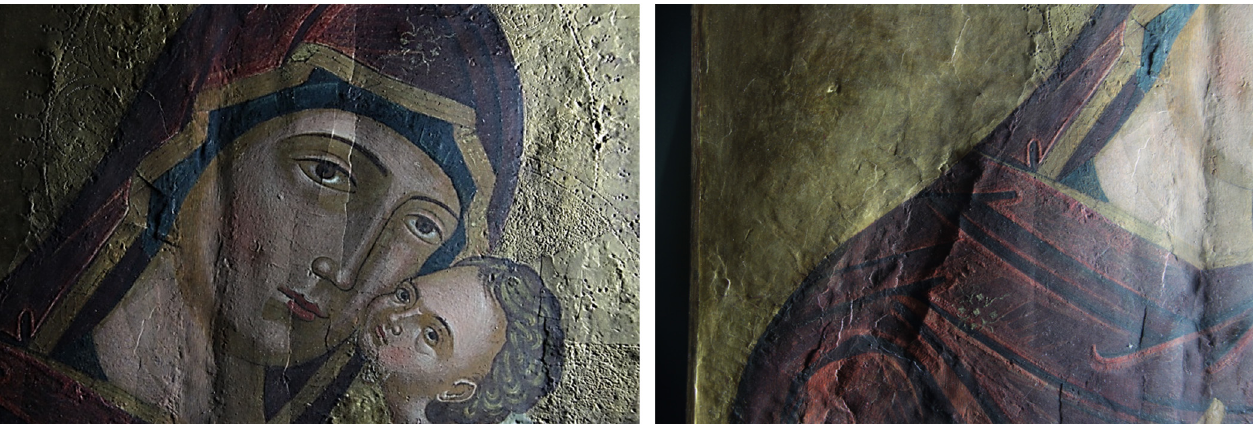
Figure 3. Vis grazing: Detail, face of the Madonna and Child Jesus in which are lesions and an unevenness of the surface, some brushstrokes in relief, and the incisions of the halos can be observed ( left ); irregularities in the pattern of the pictorial surface ( right ).